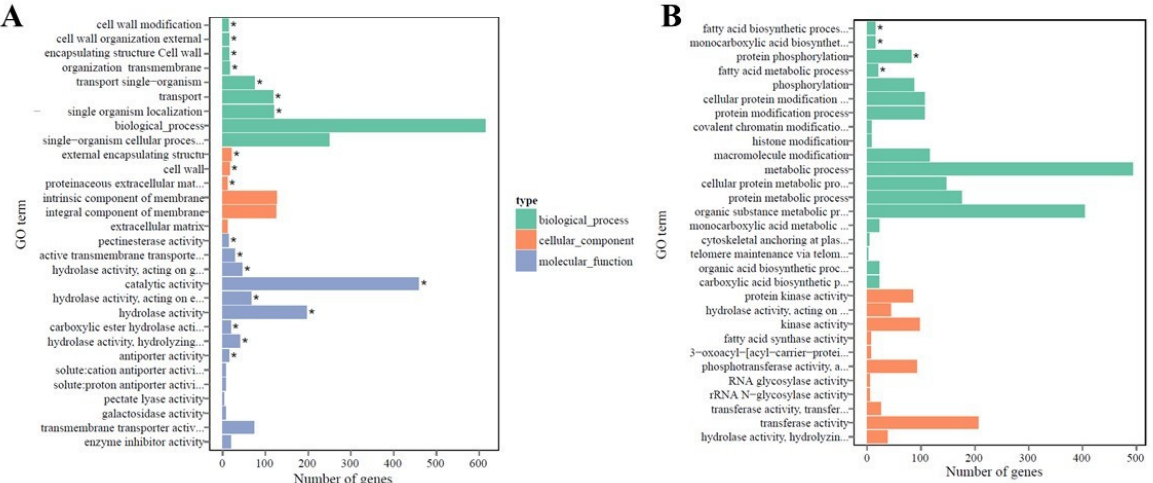
Figure 3. GO enrichment bar chart of DEGs: Gene Ontology (GO) of ( A ) upregulated and ( B ) downregulated differentially expressed genes (DEGs) in PI 175311 leaf tissue. The y-axis represents the enriched GO term, x-axis represents the number of DEGs enriched in the listed term. Colors represent different GO types: biological process, cellular component and molecular function. * GO with corrected p -value < 0.05 significantly enriched in DEGs.